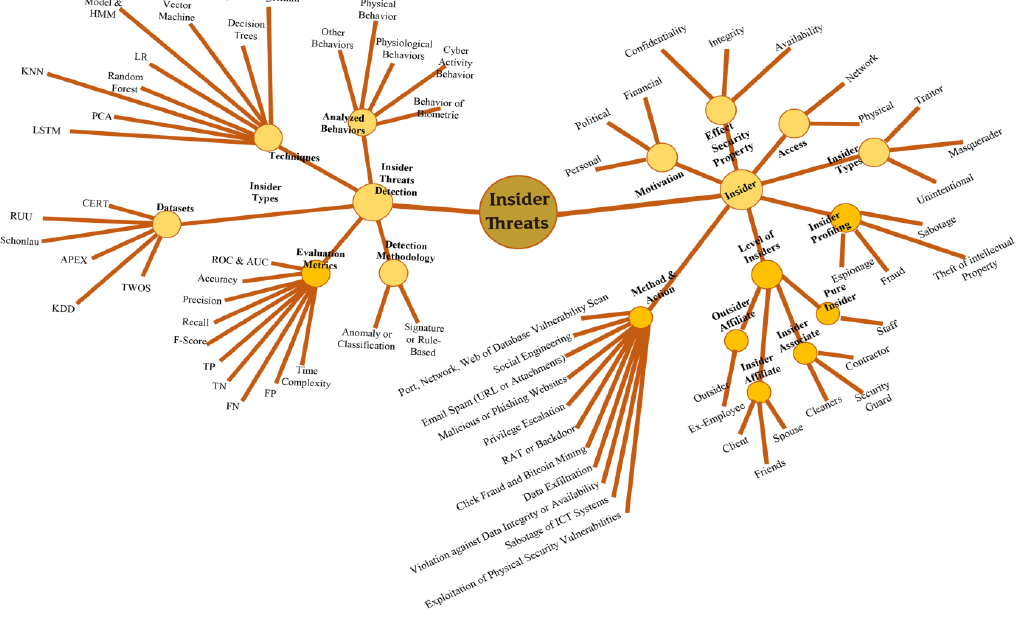
Figure 2. Classifications of insider threats.